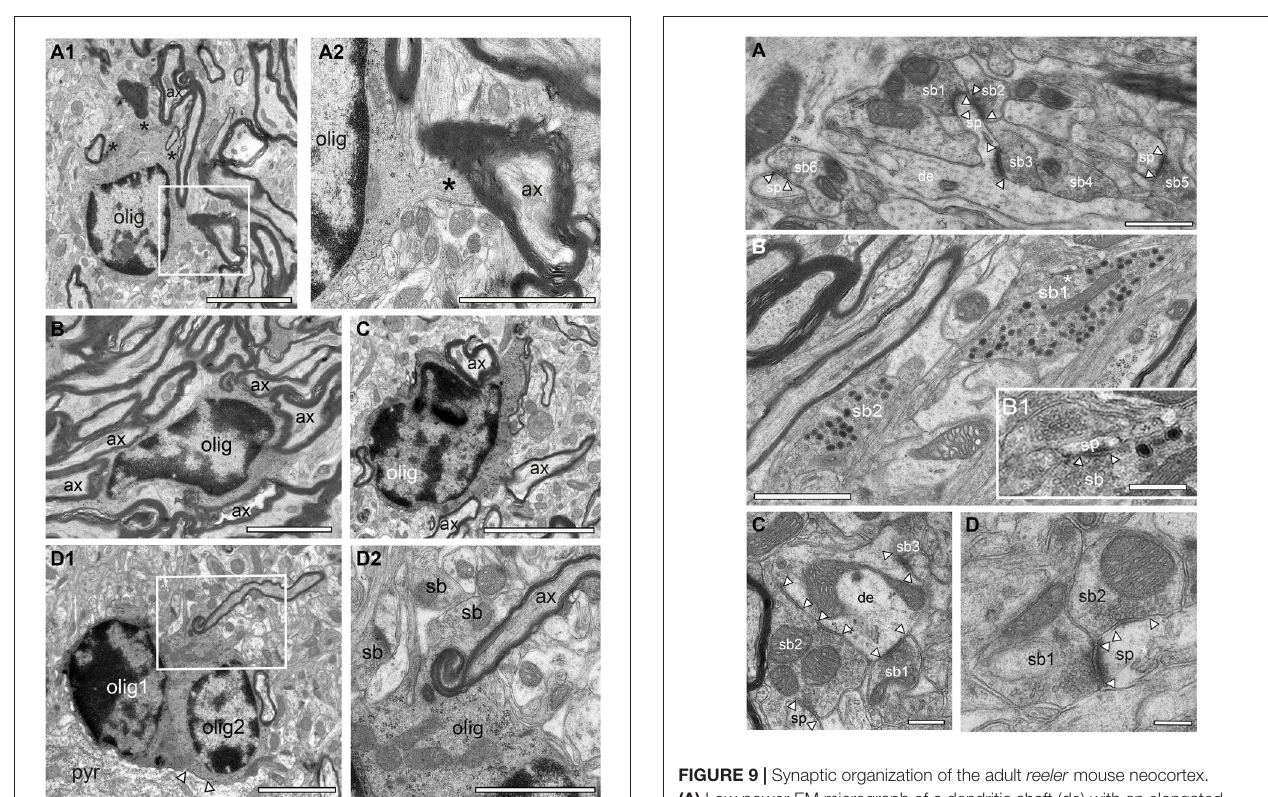
FIGURE 9 | Synaptic organization of the adult reeler mouse neocortex. (A) Low power EM micrograph of a dendritic shaft (de) with an elongated spine (sp). Note the establishment of two synaptic boutons (sb1, sb2) on the spine head and one on a spine neck (sb3). In the surrounding neuropil several other synaptic boutons (sb4–6) terminating on spines (sp) were found. Scale bar 0.5 µ m. (B) Two large synaptic boutons (sb1, sb2) located within a massive fiber bundle in the superficial part of the neocortical mass one of which is shown in the framed area in Figure 5B . Note the high number of large dense core vesicles distributed throughout the entire bouton. Scale bar 0.5 µ m. (B1) High magnification of the region marked by an asterisk in (B) showing an active zone at a small spine (sp). Note also the two large dense core vesicles in close proximity to the active zone. Scale 0.25 µ m. (C) Small caliber dendrite (de) with three synaptic boutons (sb1–3) two of which are putative glutamatergic terminals (sb1, sb3) as indicated by the shape of synaptic vesicles and that of the active zone. Sp2, a possibly GABAergic bouton innervates two postsynaptic targets, a dendrite (de) and a spine (sp). Scale bar 0.25 µ m. (D) Double innervation of a spine (sp) by two different synaptic boutons (sb1 putative glutamatergic) and sb2 (putative GABAergic) as indicated by the shape and size of the active zone, the lack of a prominent PSD (sb2) and the shape of synaptic vesicles. The spine apparatus is marked by an asterisk. Scale bar 0.2 µ m. In all images, active zones are marked by